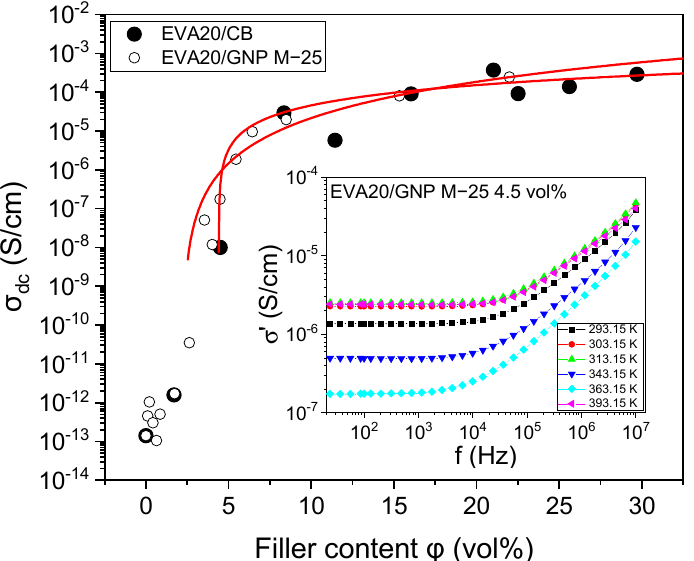
Figure 1. Conductivity at 23.7 Hz and 363.15 K as a function of filler loading for EVA20/CB and EVA20/GNP M − 25, indicating the percolative behaviour. The solid lines are fit to Equation (5). In the inset, an example is presented of frequency-dependent conductivity as a function of temperature for the EVA20/GNP M − 25 filled to 4.5 vol%. The frequency-independent DC conductivity can be extracted from the plateau observed at low